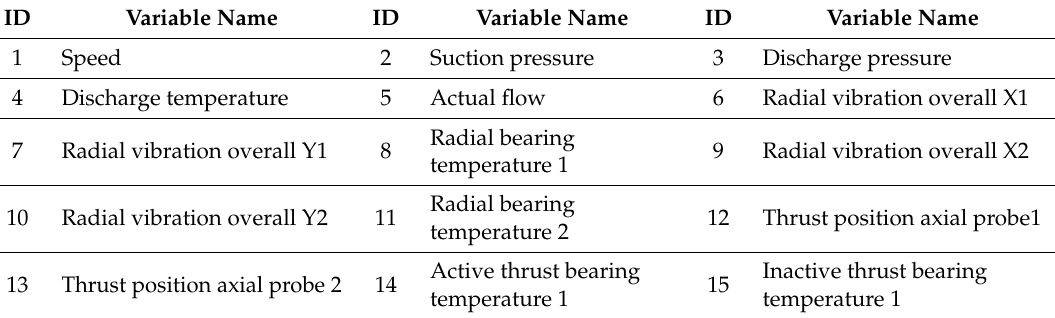
Table 1. Measurement variables in the pump monitoring